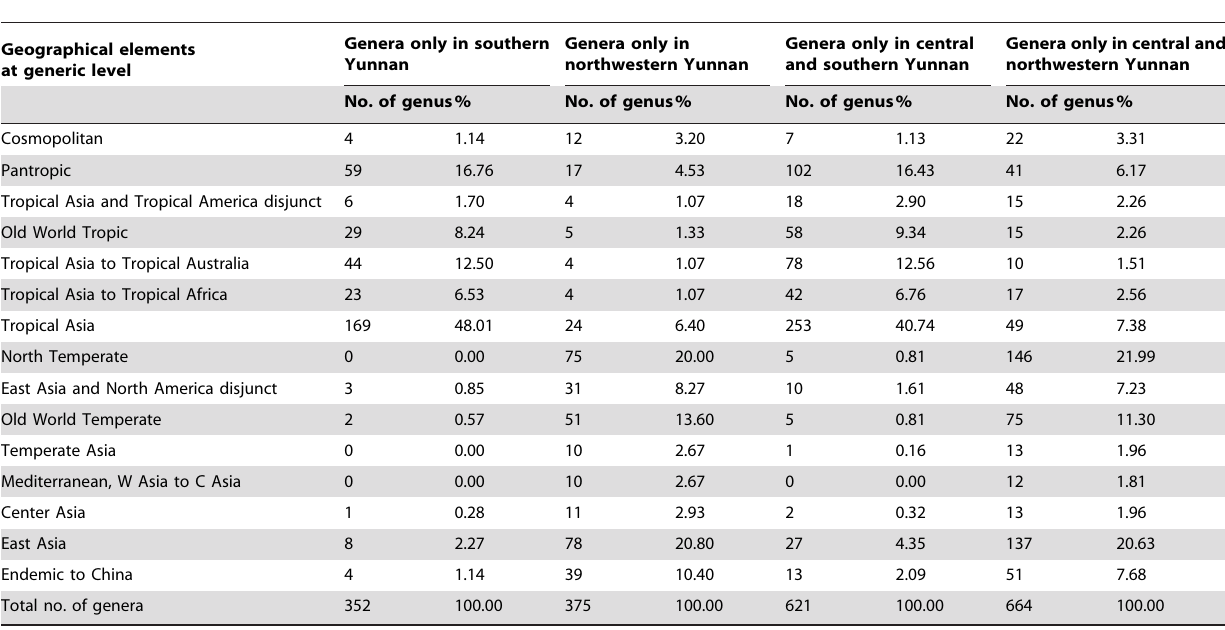
Table 6. Ggeographical elements of seed plants at the generic level in these floras respectively and shared by two of them.